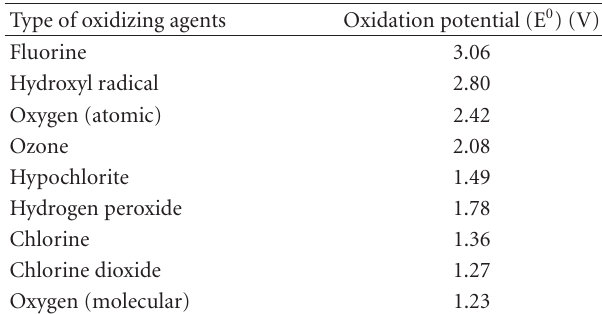
Table 2: Oxidizing potential of some oxidizing agents